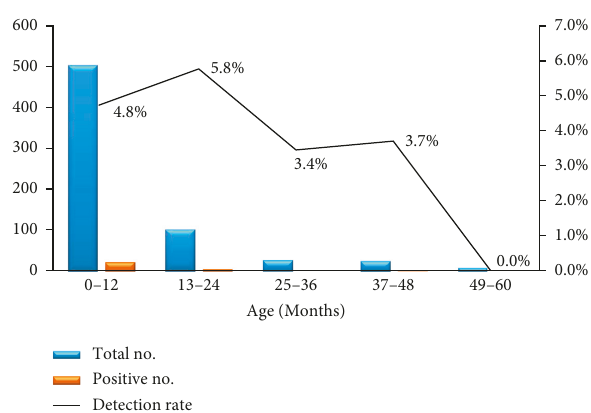
Figure 2: Age distribution of HAdV infection among hospitalized children with acute diarrhea in Shanghai between January 2006 and December 2011.